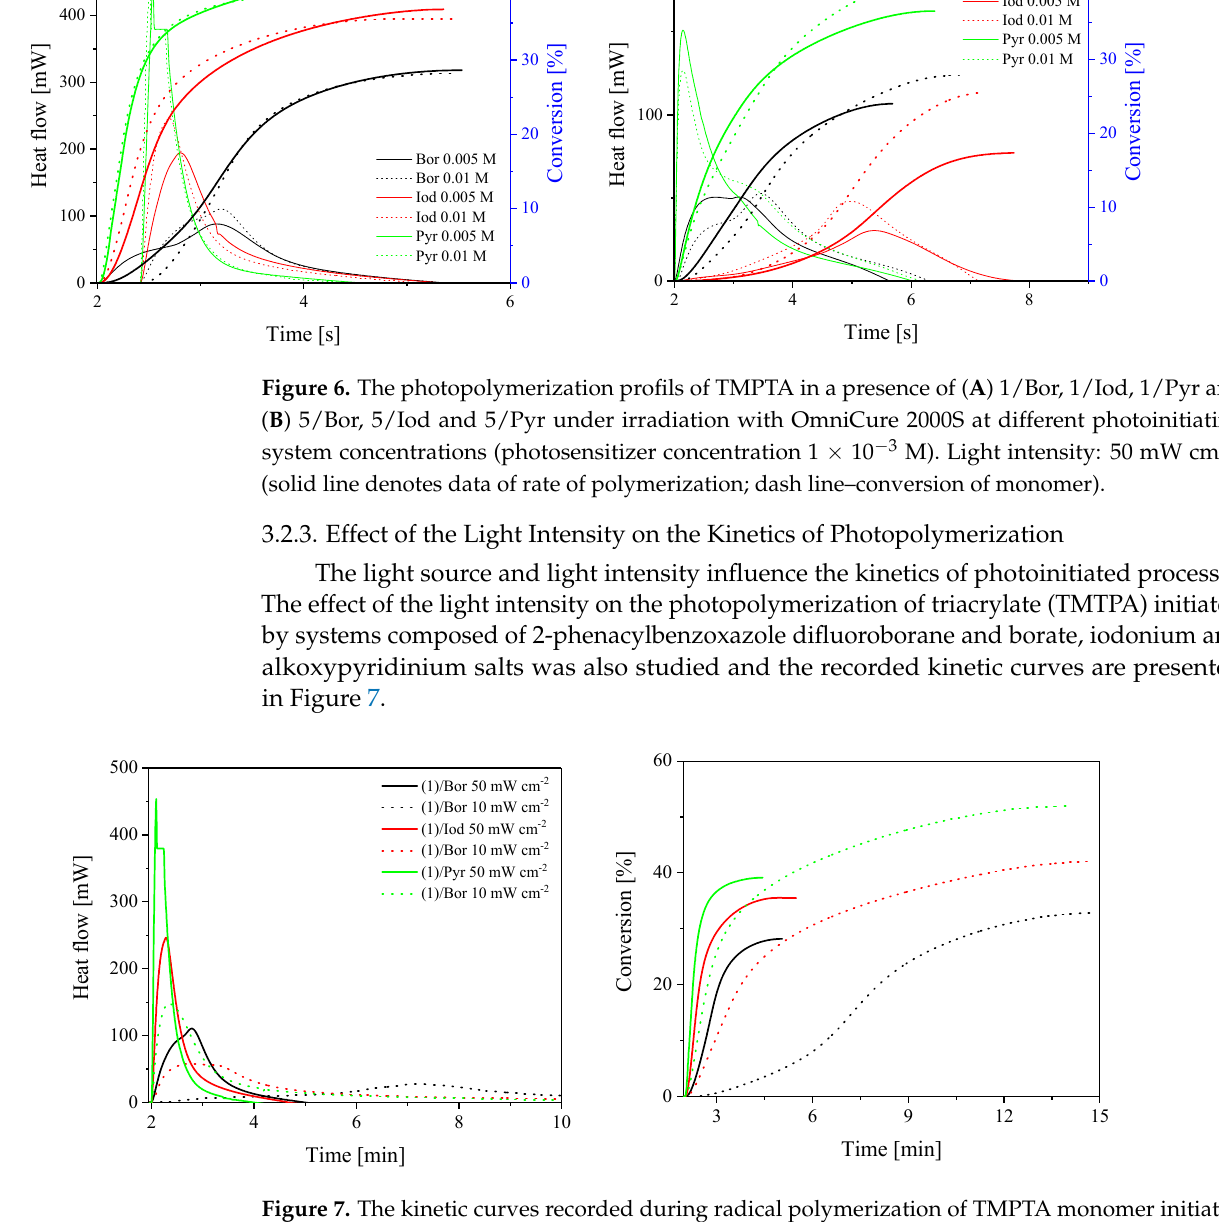
Figure 7. The kinetic curves recorded during radical polymerization of TMPTA monomer initiated by photoinitiating system composed of dye (1) (1 × 10 − 3 M) and co-initiator marked in the figure (1 × 10 − 2 M), light intensity was 10 mW cm − 2 and 50 mW cm − 2 .